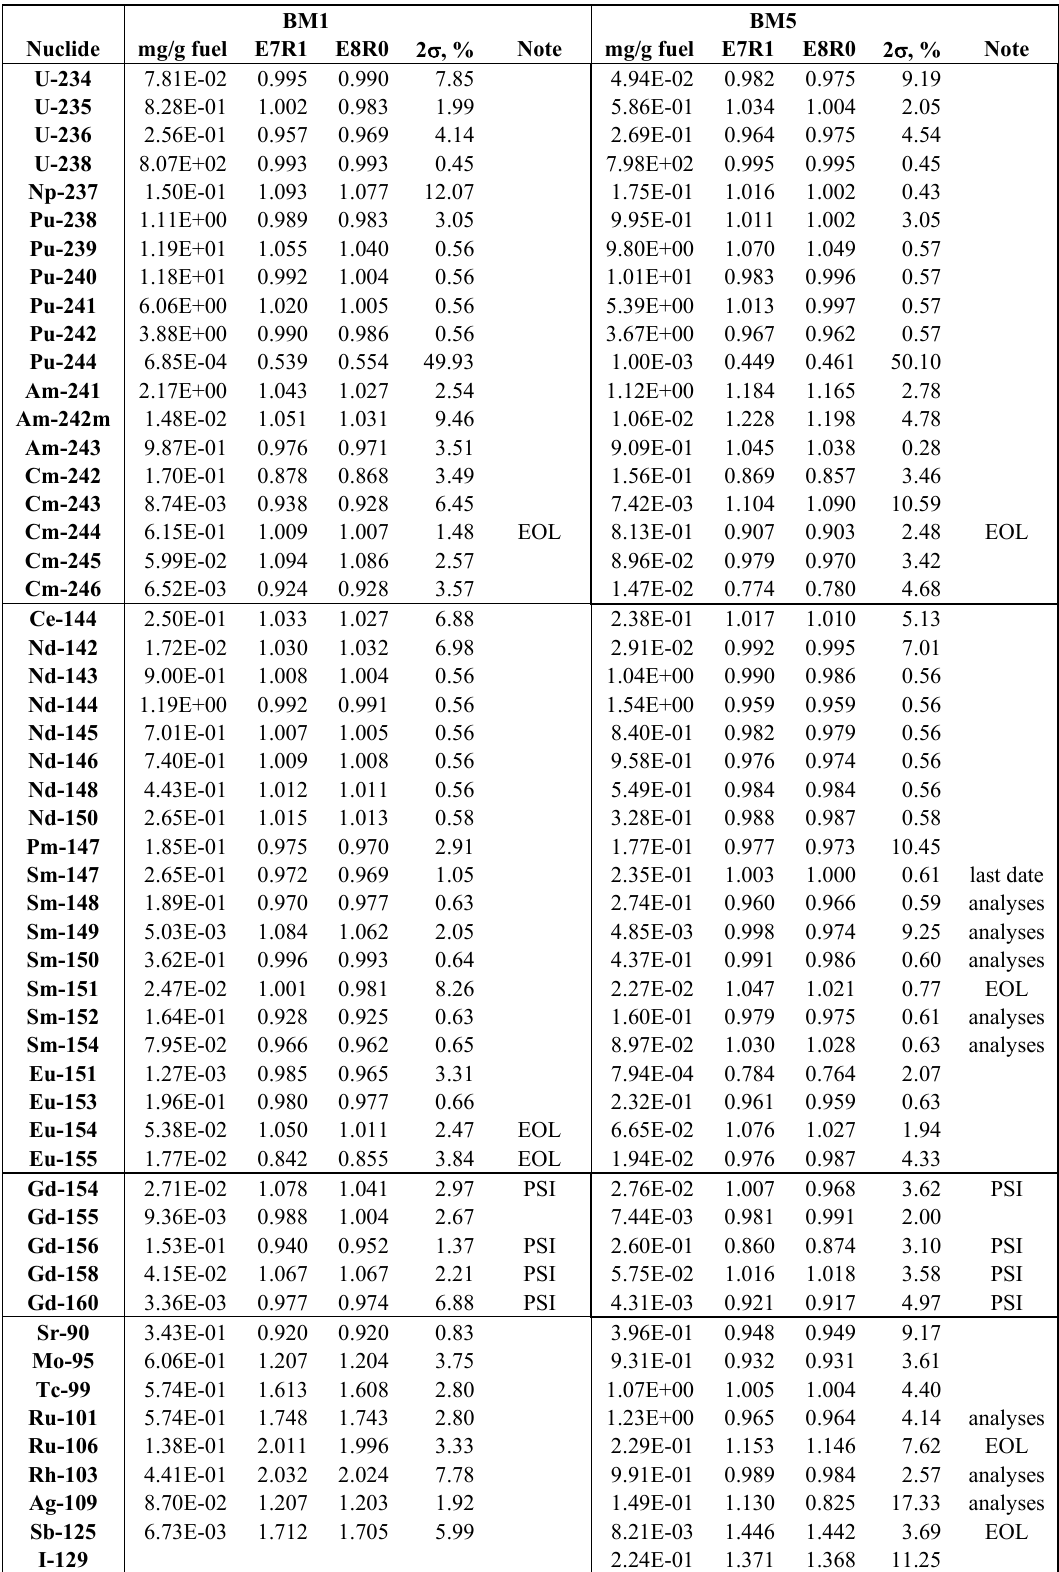
Table III. C/E comparison between CMS5/SNF calculation and BM1 and BM5 samples. BM1